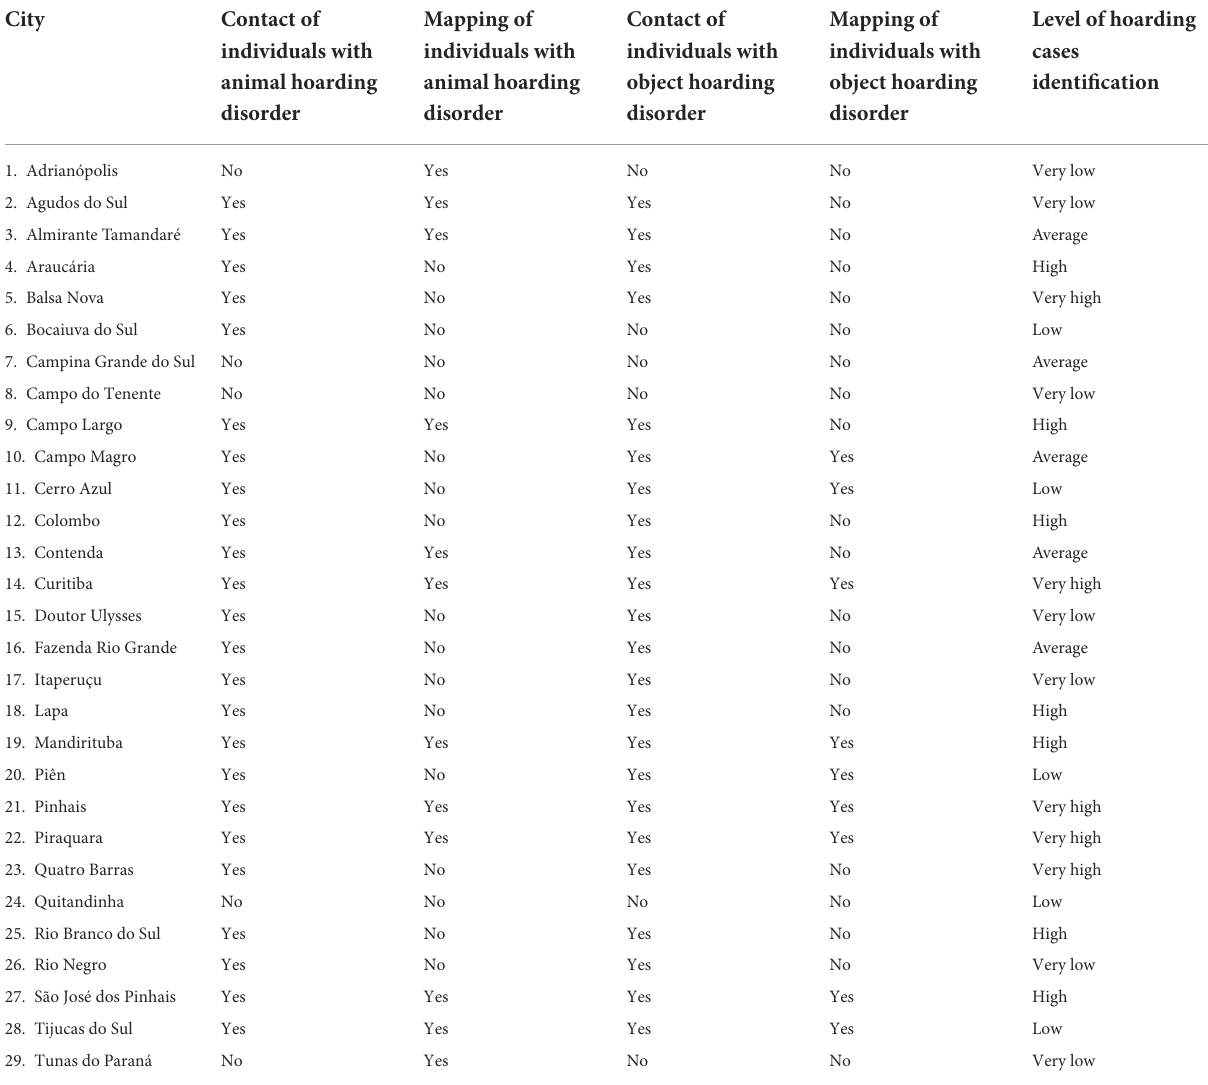
TABLE 1 Indicators and levels of hoarding cases identification out of 29 cities included in the metropolitan area of Curitiba, Parana State, Brazil * .